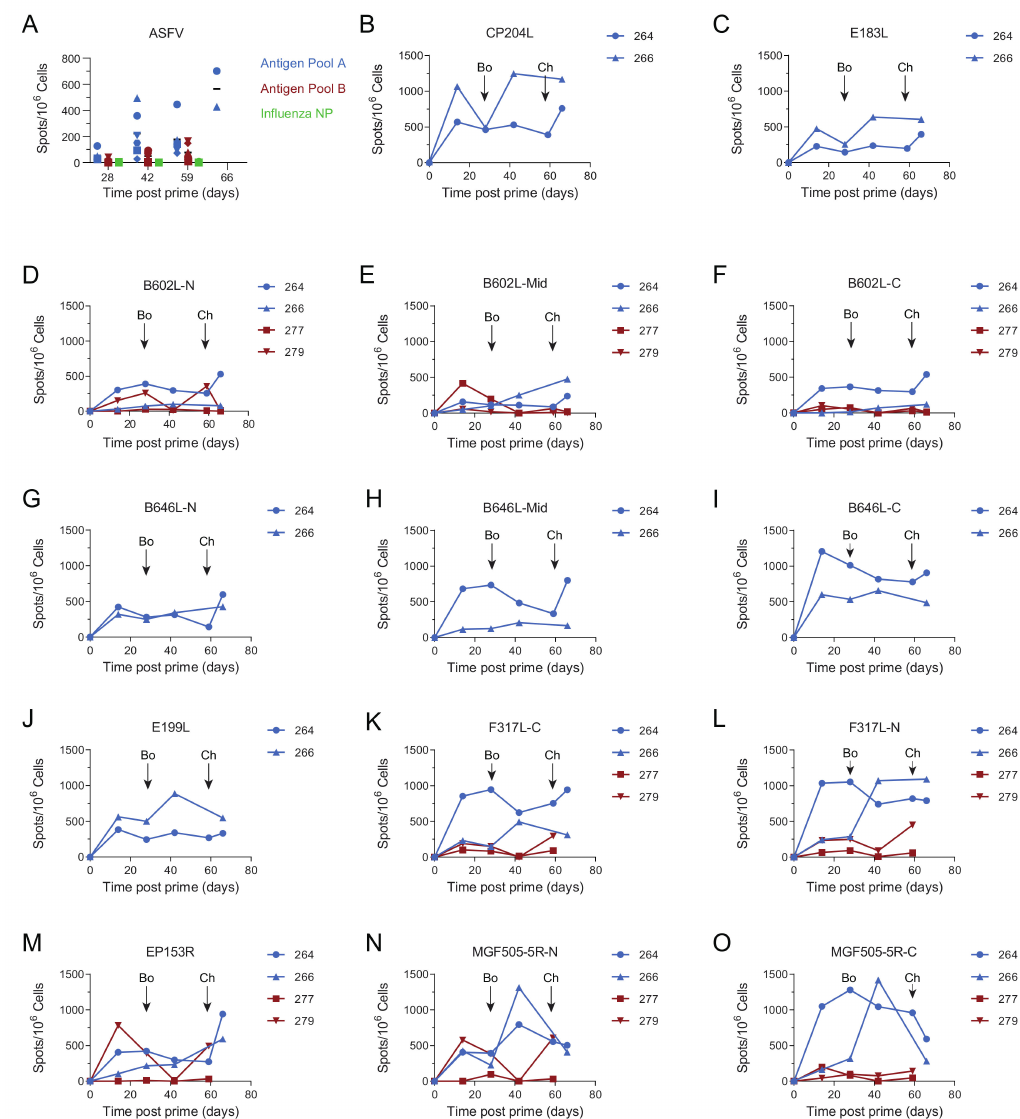
Figure 2. Virus and antigen-specific IFN γ responses in animals from experiment 1 immunized with Antigen Pool A (blue), Antigen Pool B (red) or Influenza NP (green). ( A ) The number of ASFV-specific IFN γ producing peripheral blood mononuclear cells (PBMC) were enumerated by ELIspot, on the indicated days post-prime, following in vitro stimulation with ASFV or peptides. Data points indicate the number of spots per million cells induced by the whole virus after background subtraction. ( B – O ). The number of IFN γ -producing PBMC stimulated by pools of peptides was enumerated by ELIspot on the indicated days post-prime. N, mid and C indicate pools of peptides that correspond to the N-terminus, mid-section or C-terminus of the proteins encoded by B602L, B646L, F317L and MGF505-5R . Data points indicate the number of spots per million cells induced by the pool of peptides after background subtraction, error bars indicate standard deviation from the mean. Note that to aid clarity the scale for the virus-specific responses ( A ) have been set to half the range of the peptide pools ( B – O ). Timing of boost (Bo) and challenge (Ch) are indicated on panels B to